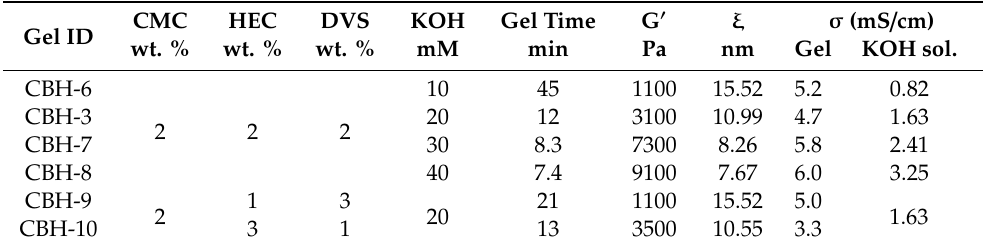
Table 2. Dependence of gel time, storage modulus (G (cid:48) ), mesh size ( ξ ) and ionic conductivity ( σ ) on KOH concentration and HEC to DVS weight ratio.